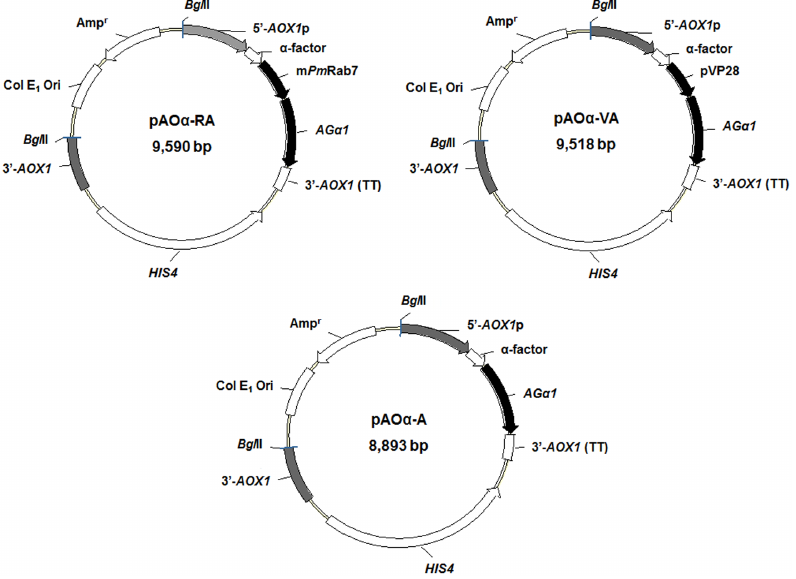
Fig 1. Physical maps of plasmids harboring m Pm Rab7 and pVP28 fused with half 3 ’ -agglutinin of S . cerevisiae for surface display by P . pastoris